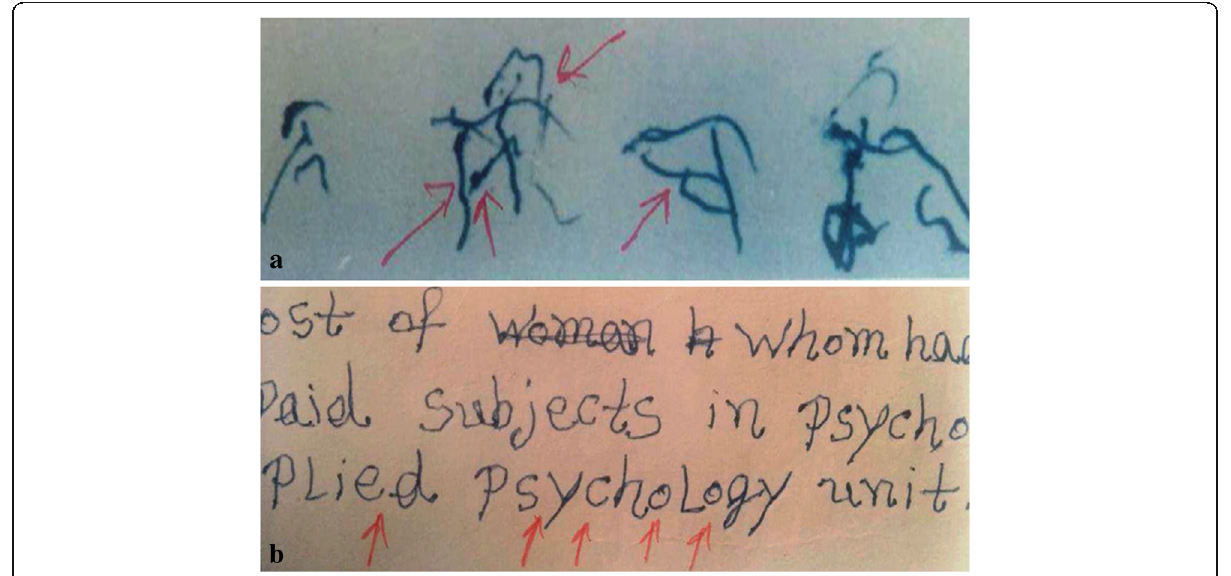
Fig. 2 Pen lifts. a Signature executed in old age showing pen lifts before writing each letter. b Handwriting sample of Parkinsonism